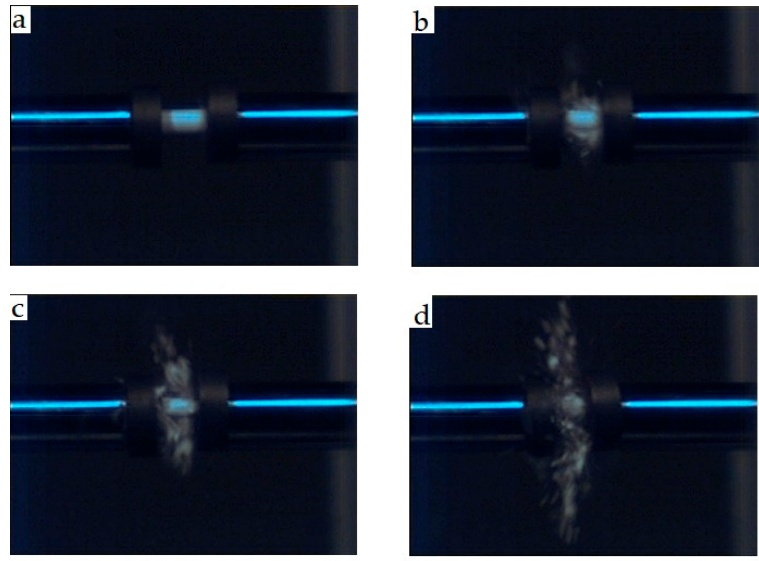
Figure 7. Failure of sample during the dynamic loading. ( a ) 0 µs; ( b ) 50 µs ; ( c ) 100 µs; ( d ) 150 µs.